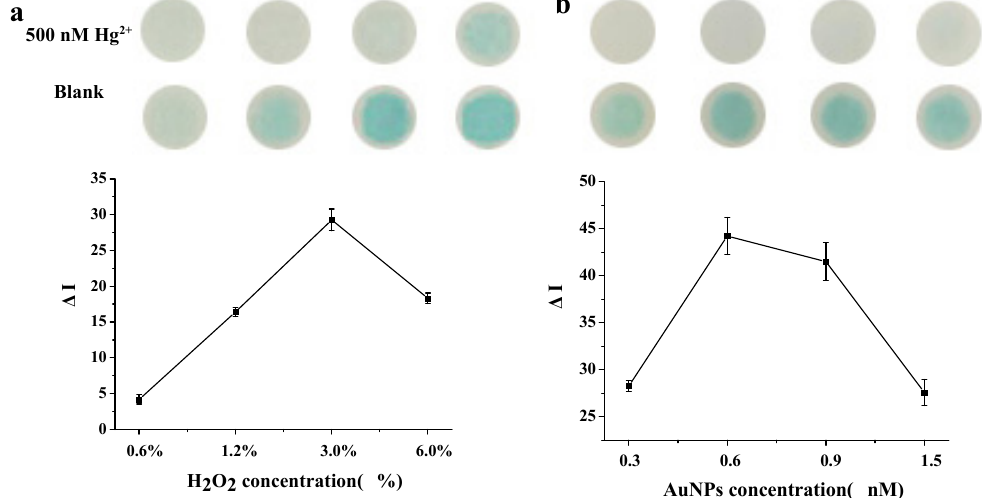
Figure 3. Optimization of H 2 O 2 and DNA–AuNP concentration. ( a ) E ff ect of H 2 O 2 concentration and ( b ) e ff ect of DNA–AuNP concentration.